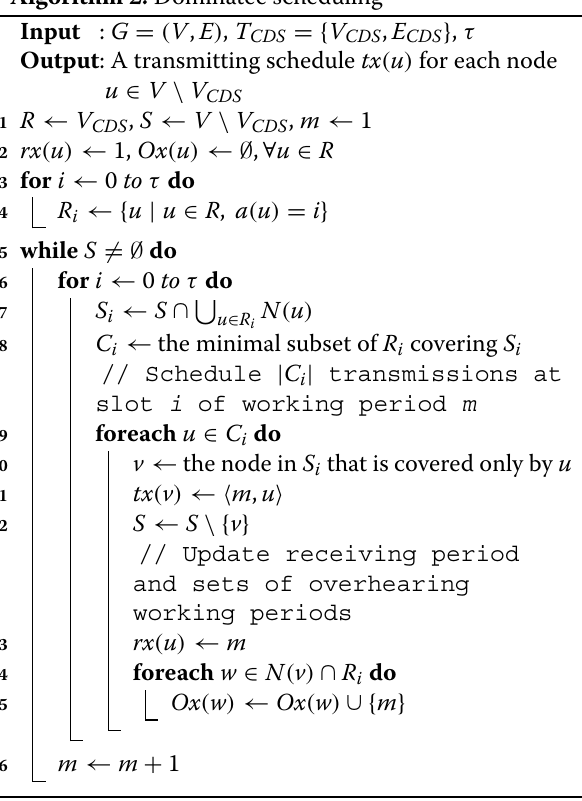
Algorithm 2: Dominatee